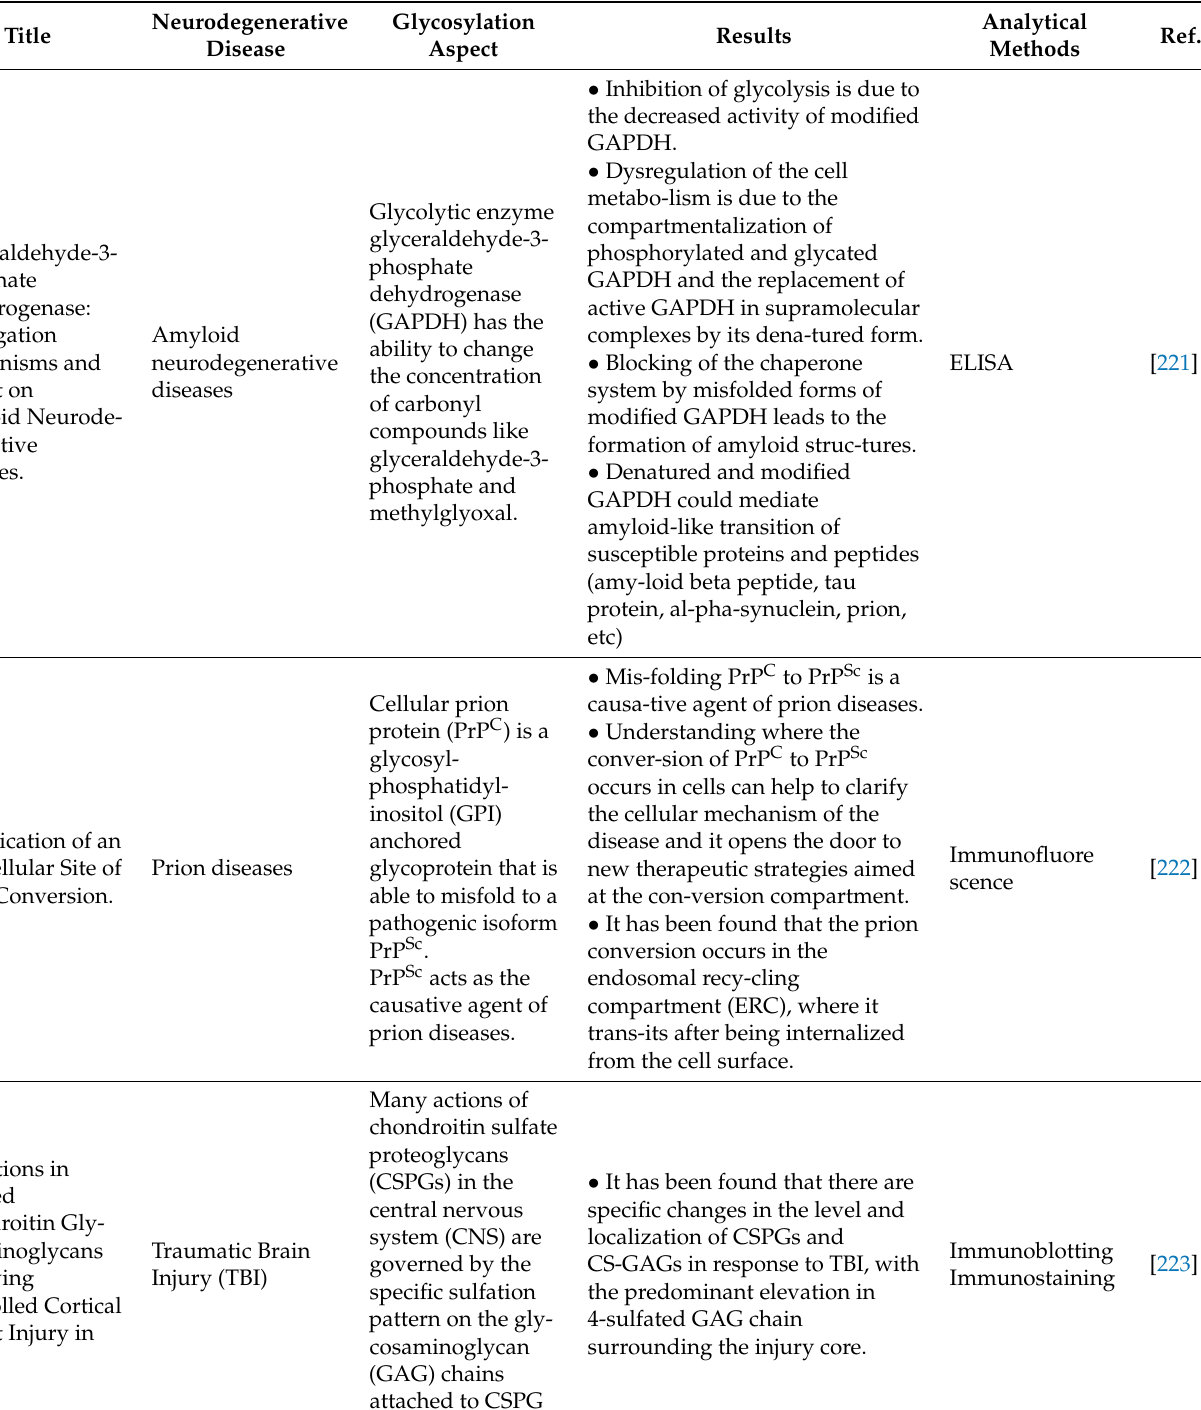
Table 3. Detailed descriptions of several neurodegenerative diseases, tackling the glycosylation changes occurring within each disease further exacerbating its consequences. These diseases include Alzheimer’s, Parkinson’s, Prion diseases, and many